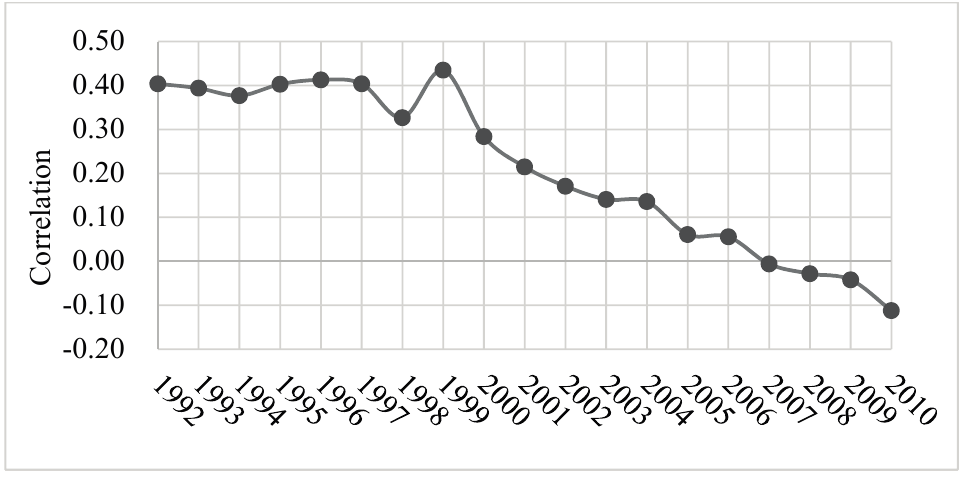
Figure 8. The correlation between mean NDVI and mean DN in the urbanization areas during 1992–2010 among all the 50 metropolises.